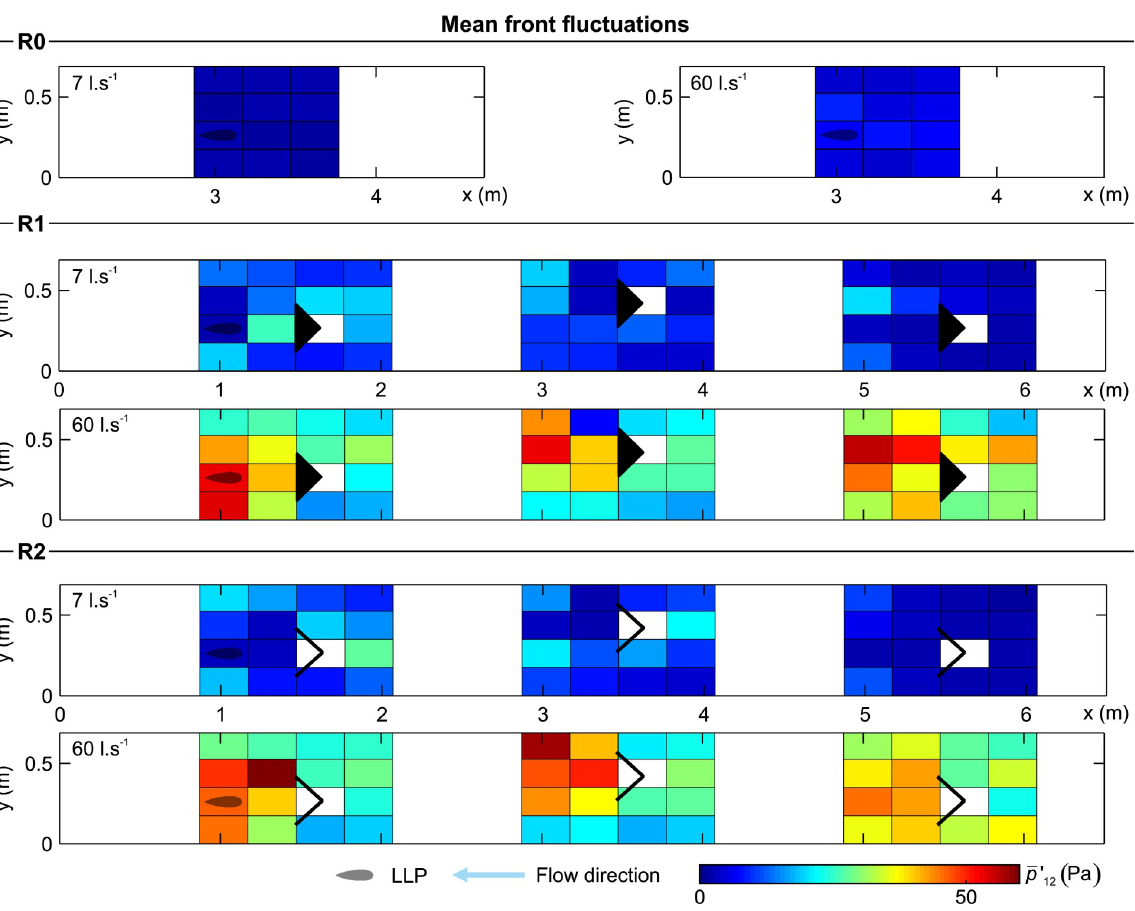
Fig 8. Distribution of mean front fluctuations ( � p 0 reader is referred to supporting information (S2 Fig) to look at the contour representation of this figure.